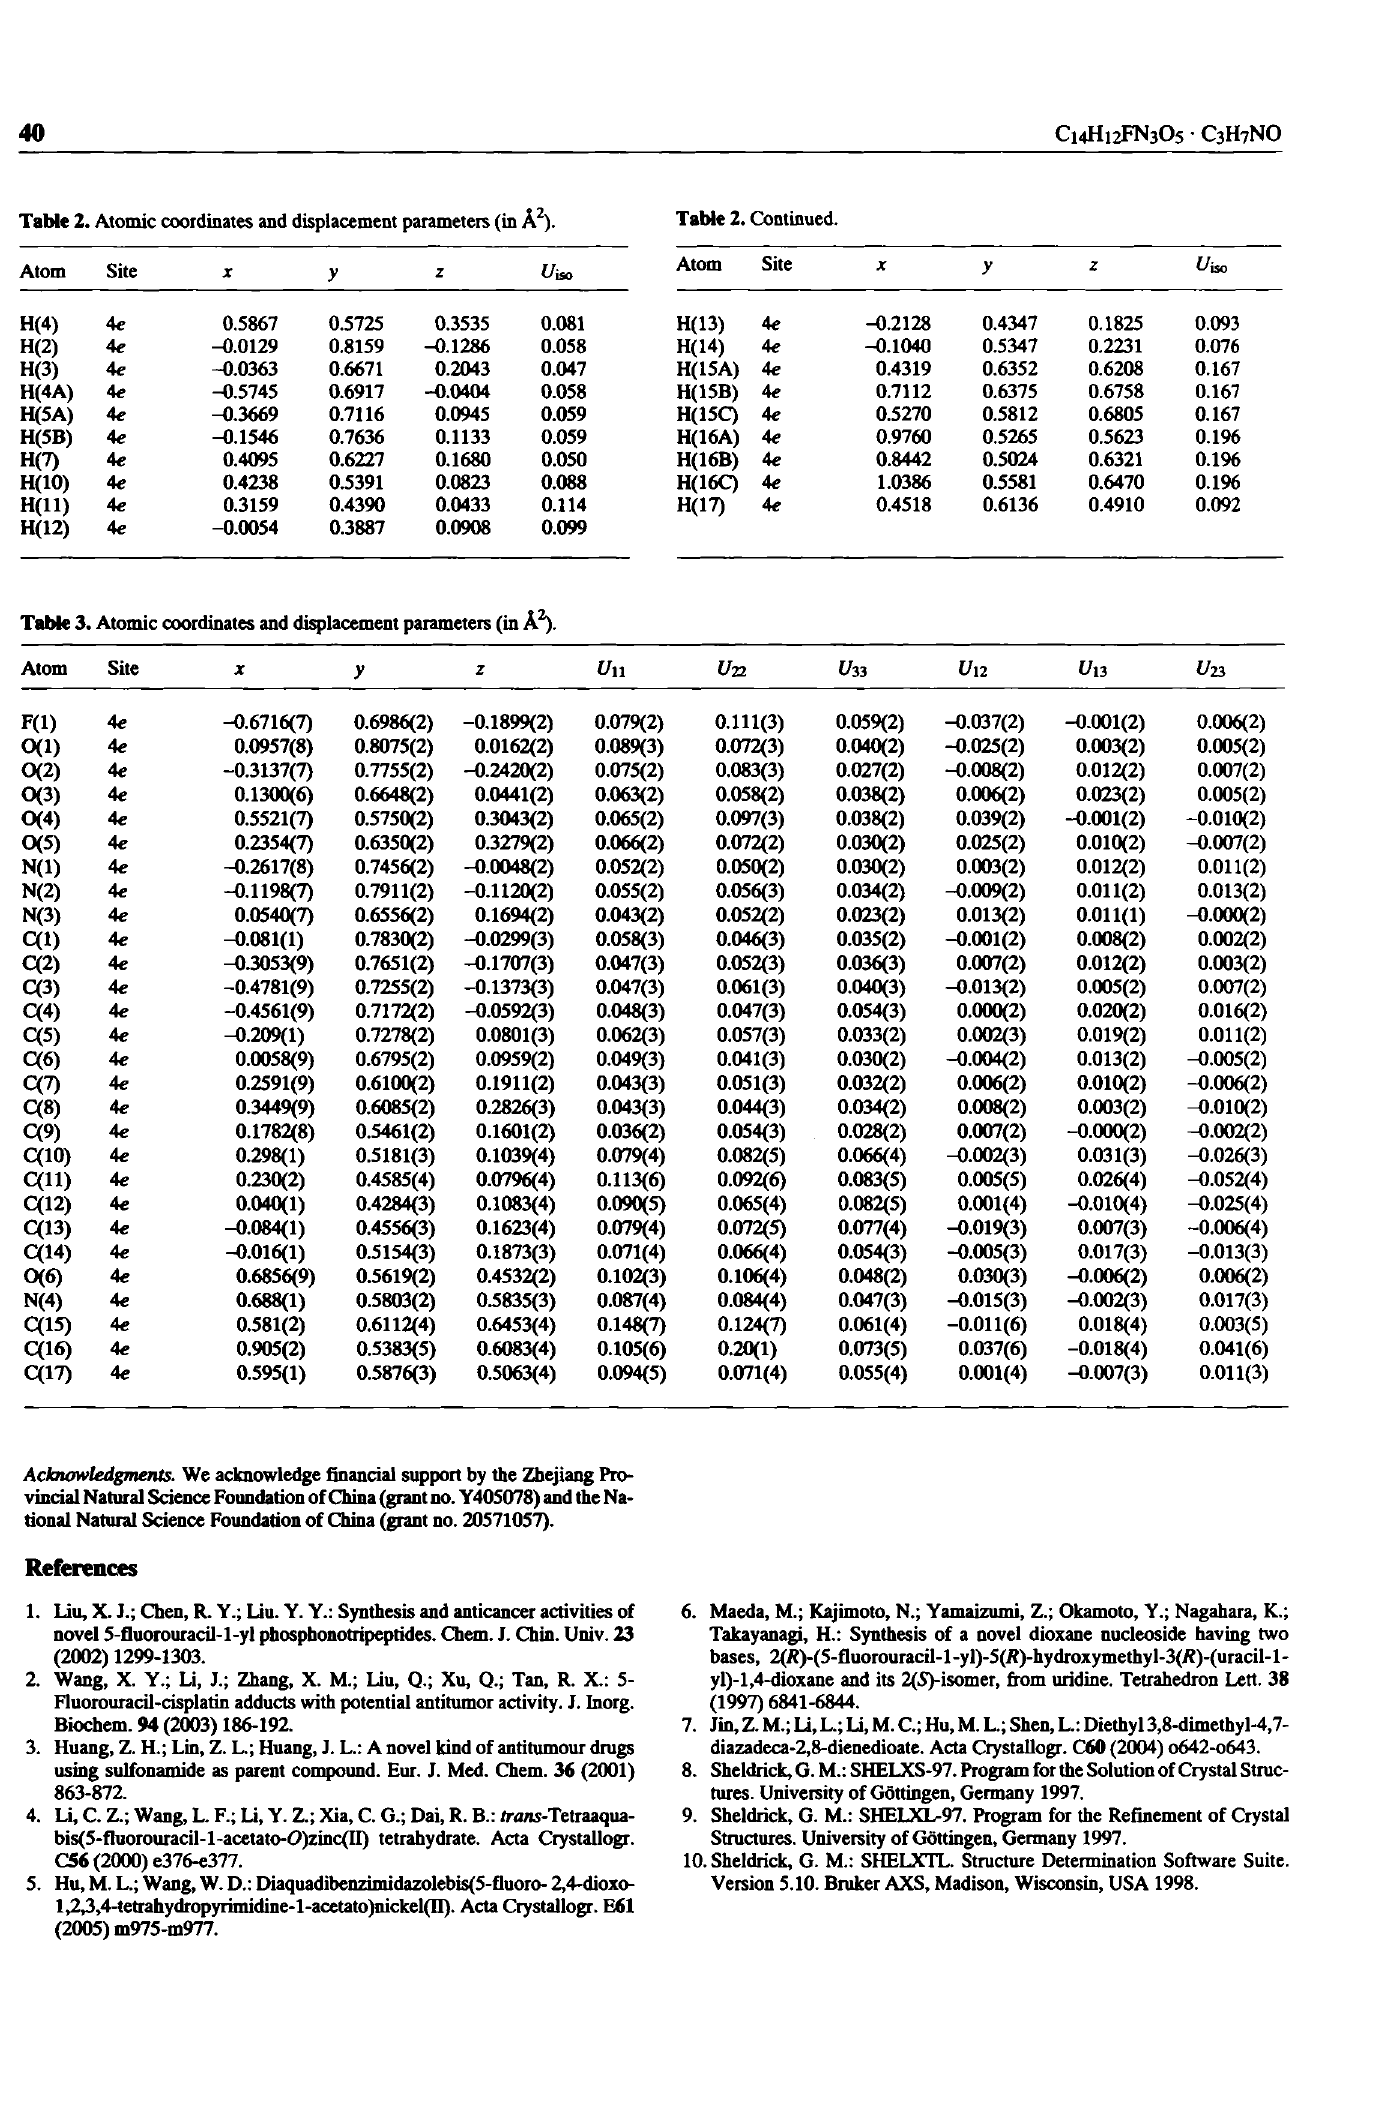
Table 3. Atomic coordinates and displacement parameters (in A 2